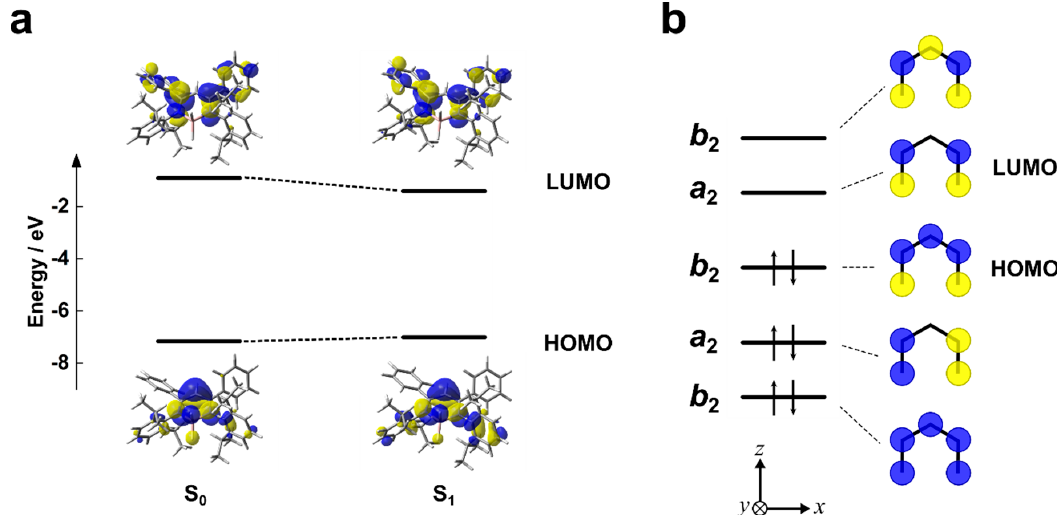
Figure 4. ( a ) Calculated energy diagrams for the optimized structures at the S 0 and S 1 states. Isovalue was set at 0.03. ( b ) Schematic representation of the orbital symmetries of the pentadienyl anion. Arrows denote electrons. Table 4. Results of TD-DFT calculations.